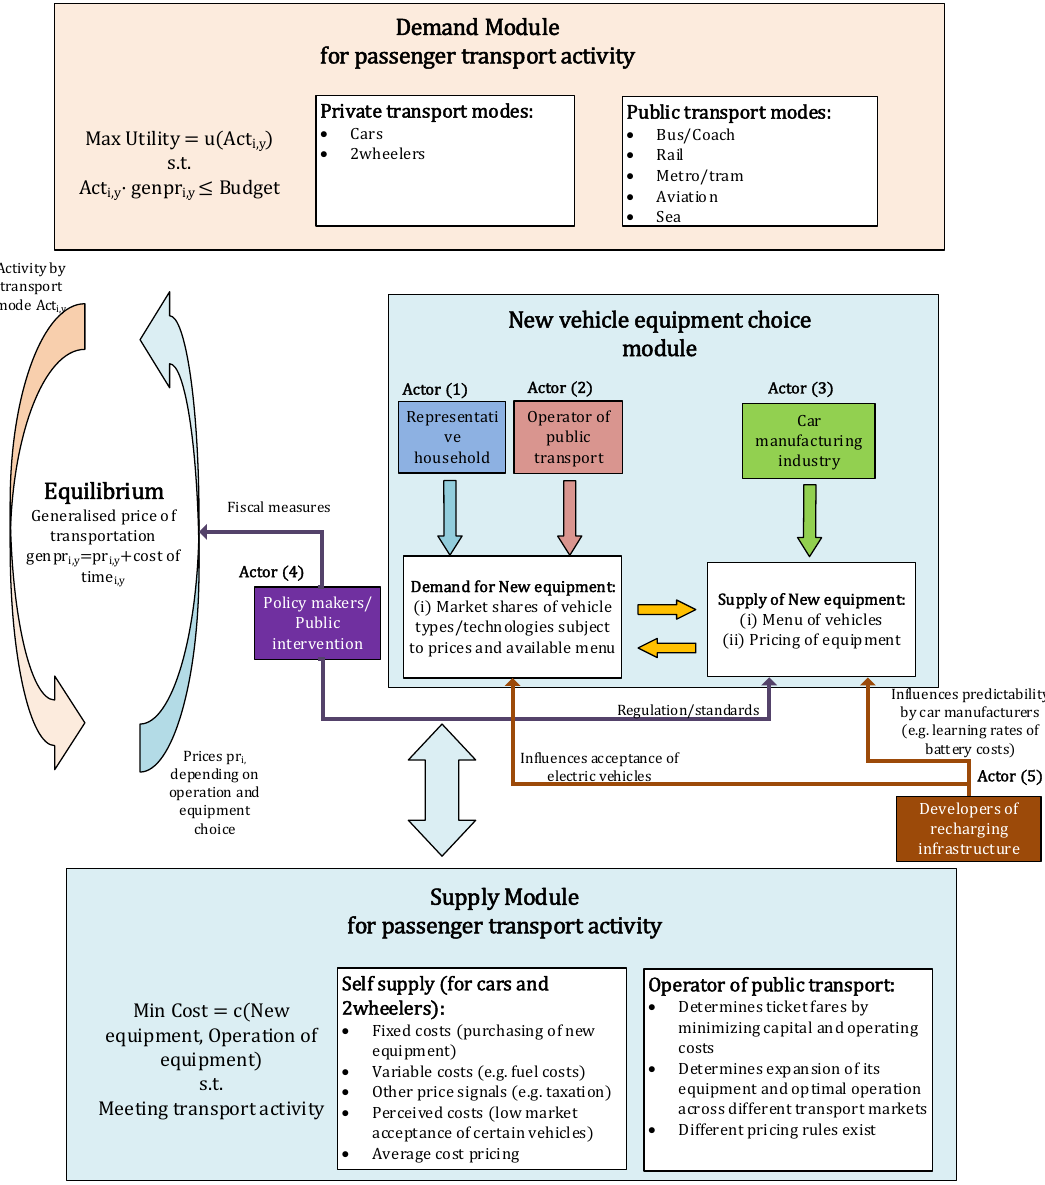
Figure 1. Schematic representation of the structure of modelling passenger transportation.